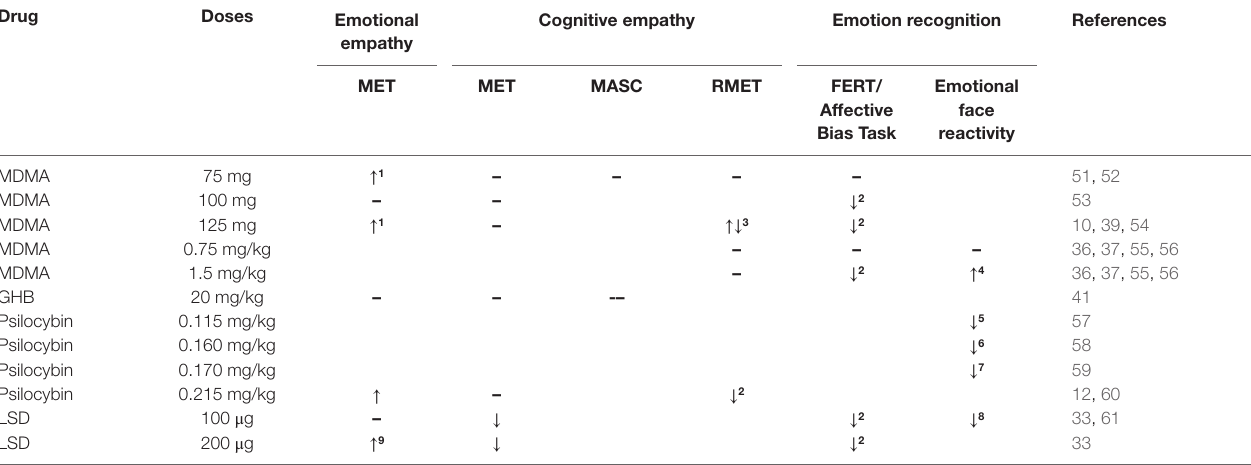
TABLE 1 | Effects of entactogens and hallucinogens on empathy, mentalizing, and emotion recognition.